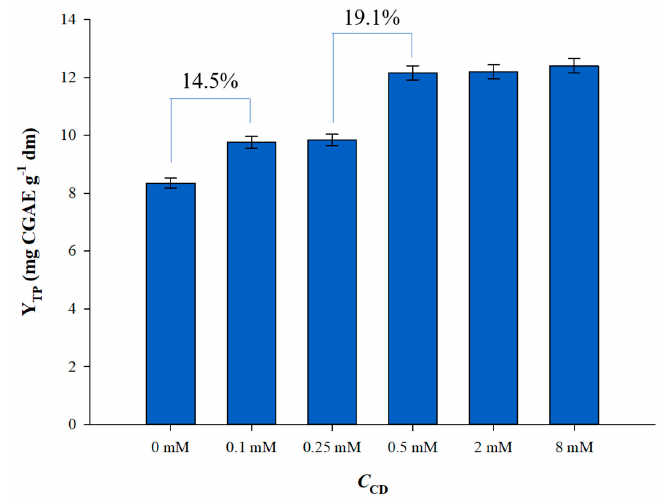
Figure 1. Effect of HP- β -CD concentration ( C CD ) on total polyphenol yield (Y TP ). Extractions were carried out at ambient temperature (29 ± 2 °C), at a liquid-to-solid ratio of 30 mL g − 1 .